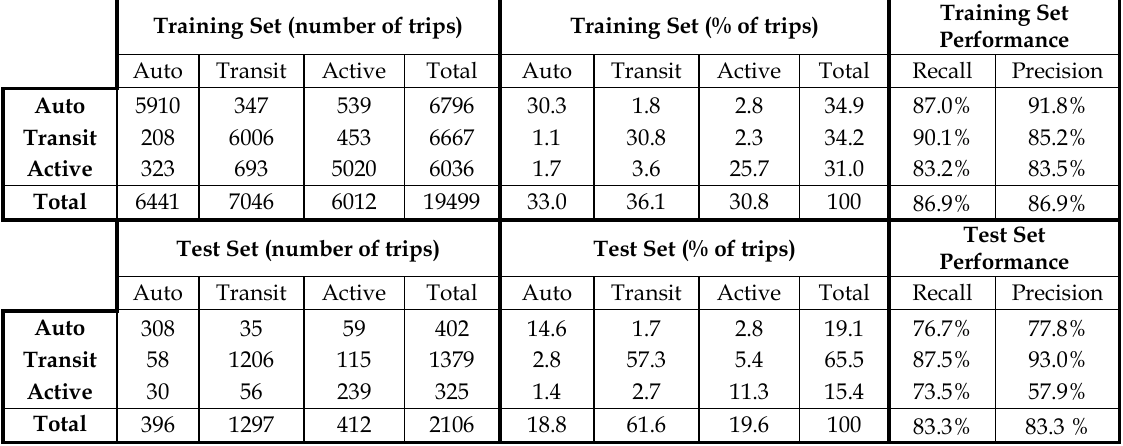
Table 2 Neural Net Model Training and Validation